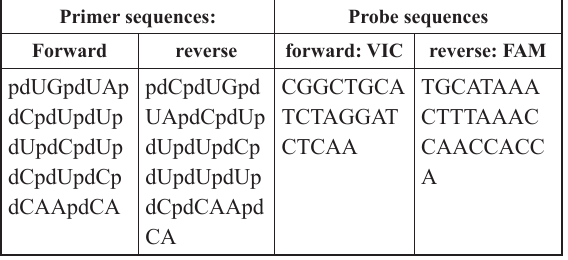
Table 2. Primers and probe sequences for ACSL (rs6552828 A/ G ) Taqman allelic discrimination